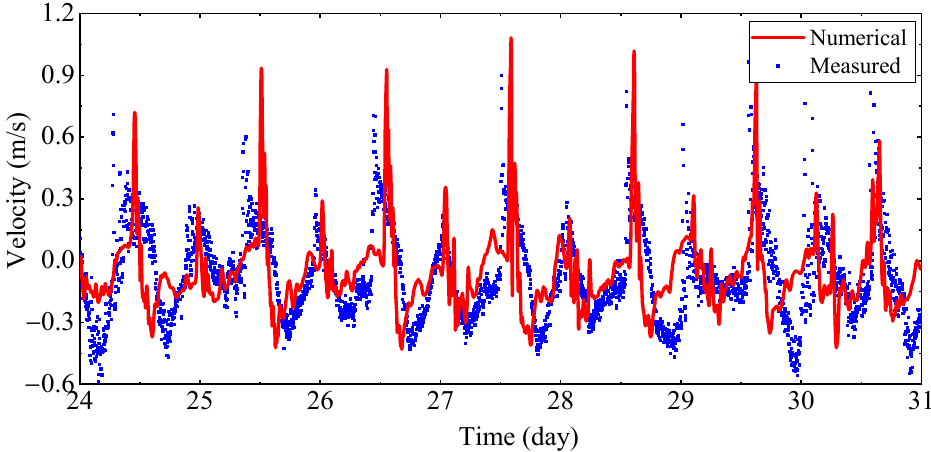
Figure 6. Comparison of simulation results and measured results of velocity of point